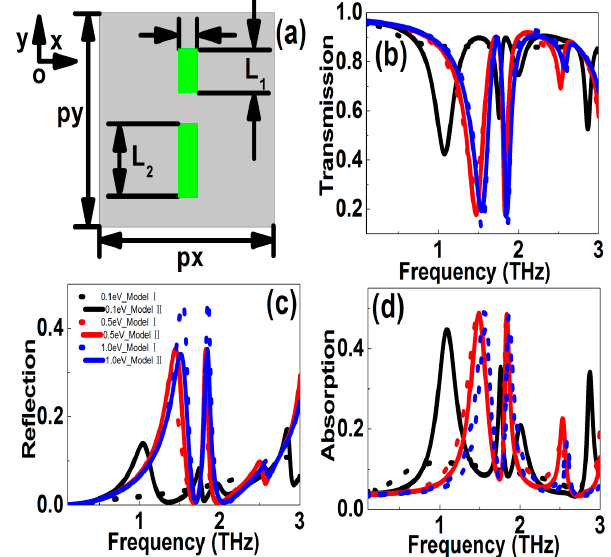
Figure 5. ( a ) is the sketch of the asymmetrical graphene stripe pattern. ( b – d ) The transmission, reflection, absorption resonant curves versus frequency, respectively. The Fermi levels were 0.1, 0.5, and 1.0 eV, respectively. The asymmetrical degree δ was δ = L 2 − L 1 . The stripe length and width were 96 μ m and 8 μ m, respectively. The periodic lengths along x and y directions were both 108 μ m.